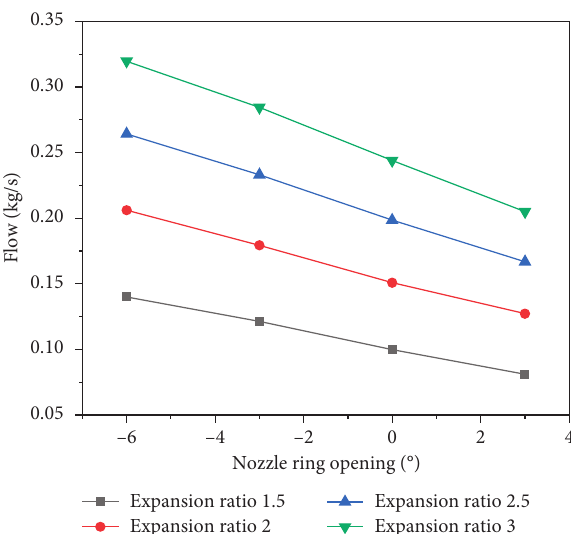
Figure 33: Relationship between opening and flow.